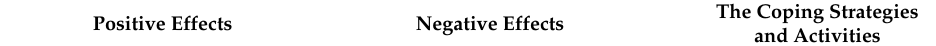
Table 4. Positive and negative effects and the coping strategies and activities.